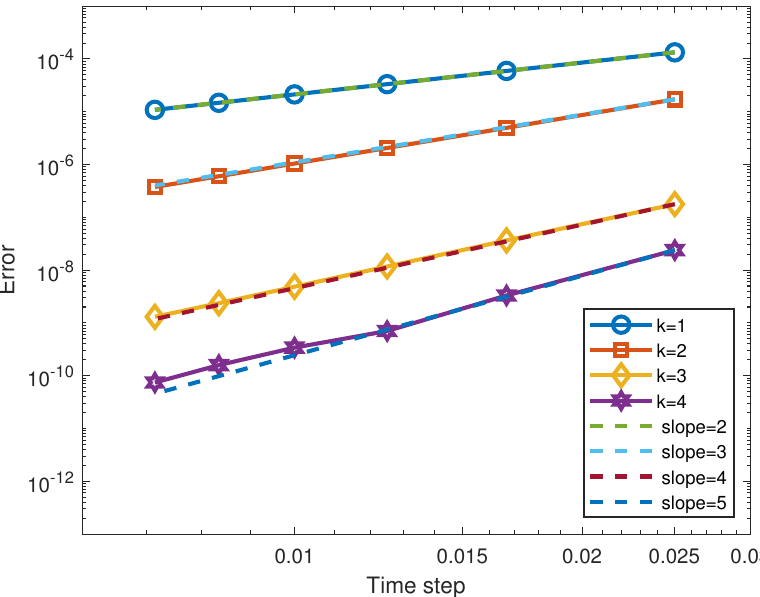
Figure 4. Errors of k -step exponential Rosenbrock multistep method for problem (24). k = 1,2,3,4. D 1 = a 1 = b 1 = r 2 = b 2 = a 2 = 1, D 2 = r 1 =